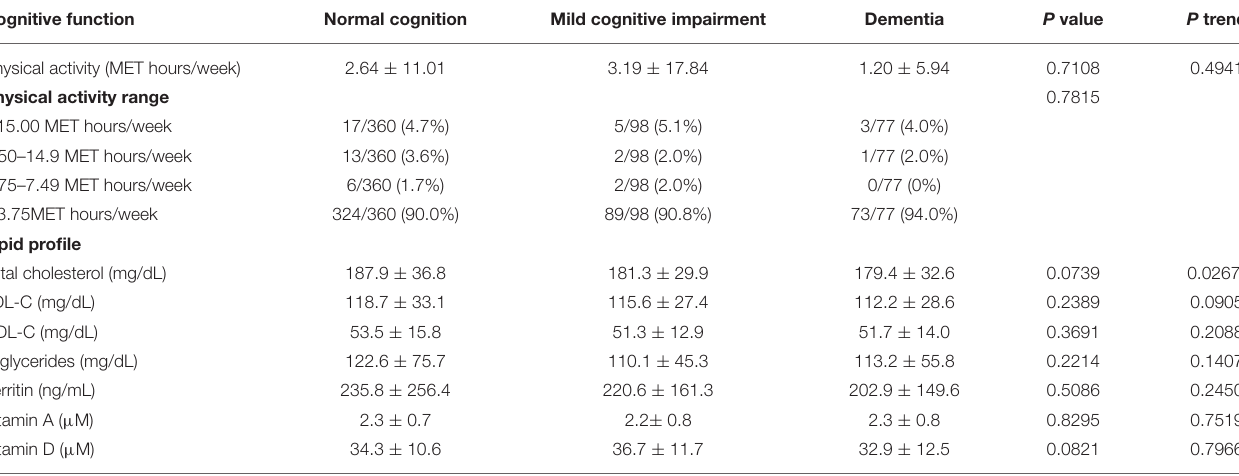
TABLE 4 | Physical activity of the three cognitive groups. Cognitive function Normal cognition